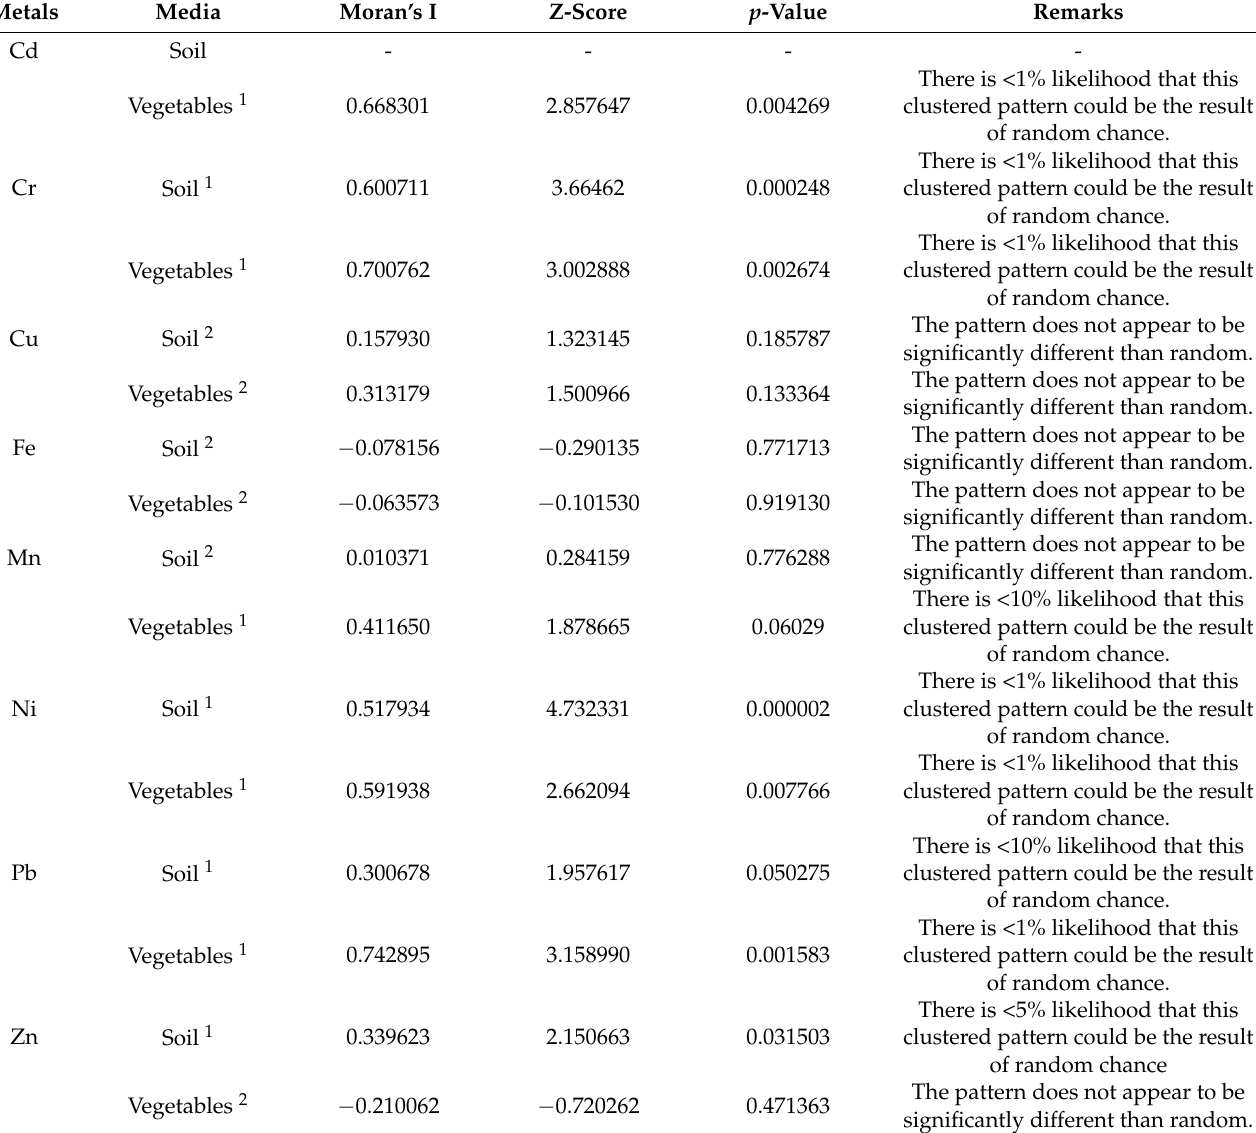
Table 10. The spatial autocorrelation and its